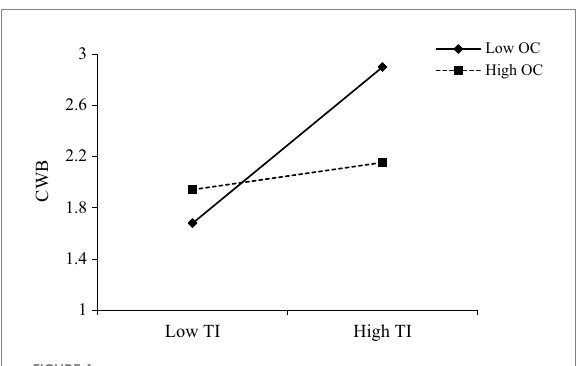
FIGURE 4 The moderating effect of organizational affective